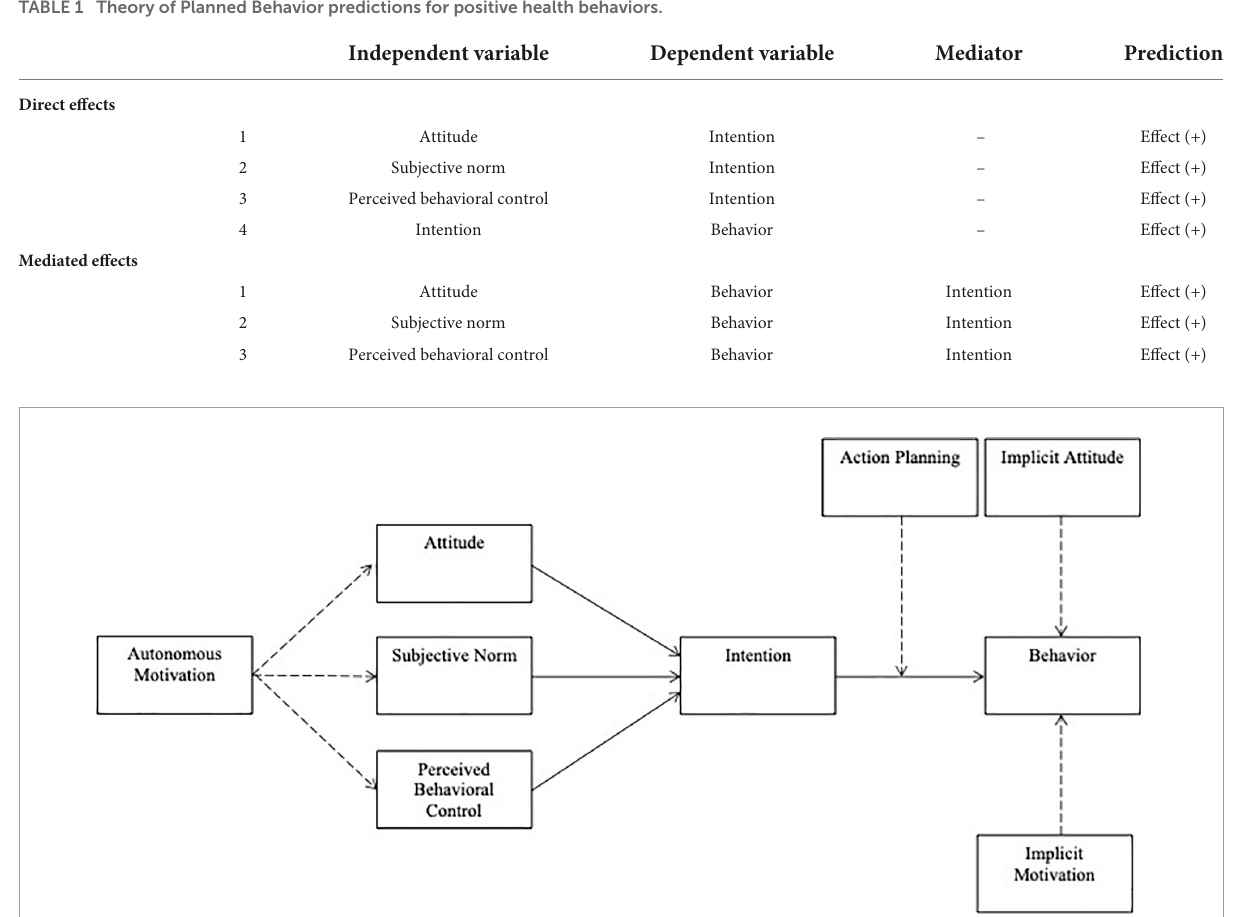
FIGURE1 The theory of planned behavior and the integrated behavior change model. The Theory of Planned Behavior is represented by the solid lines only. The Integrated Behavior Change model is an extension of the Theory of Planned Behavior and encompasses the entirety of the